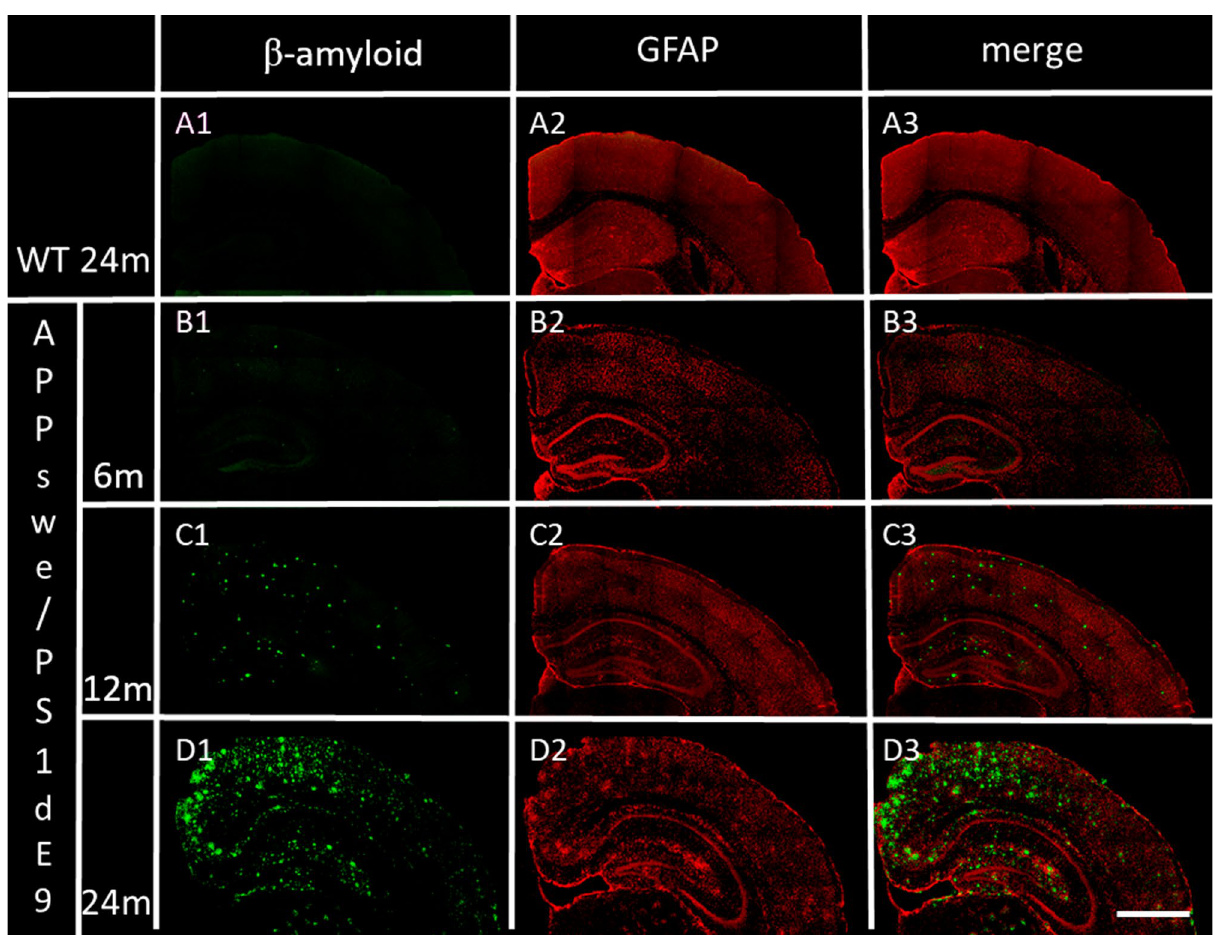
Figure 2. Distribution in cortex and hippocampus of Aβ deposits and GFAP, in WT and APPswe/PS1dE9 mice at 6-, 12- and 24-months of age (representative images). (A1) Aβ deposits in 24-month old WT mouse. (B1,C1,D1) time-dependent Aβ deposits in APPswe/PS1dE9 Tg mice. (A2) GFAP in 24-month old WT mouse. (B2,C2,D2) time-dependent GFAP in APPswe/PS1dE9 Tg mice. (A3,B3,C3,D3) previous merged images. Coronal section 50 µm (×20). Anti-Aβ (green), anti-GFAP (red). Bar 1